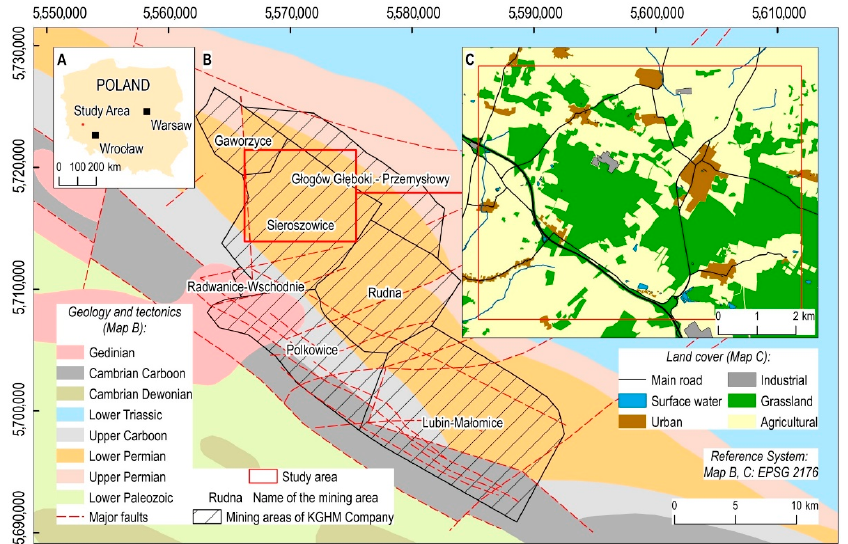
Figure 1. ( A ) Location of the case study area in the map of Poland; ( B ) mining areas belonging to the Kombinat Górniczo-Hutniczy Miedzi (KGHM) Company in the area of interest; ( C ) main built-up areas and surface infrastructure in the case study.